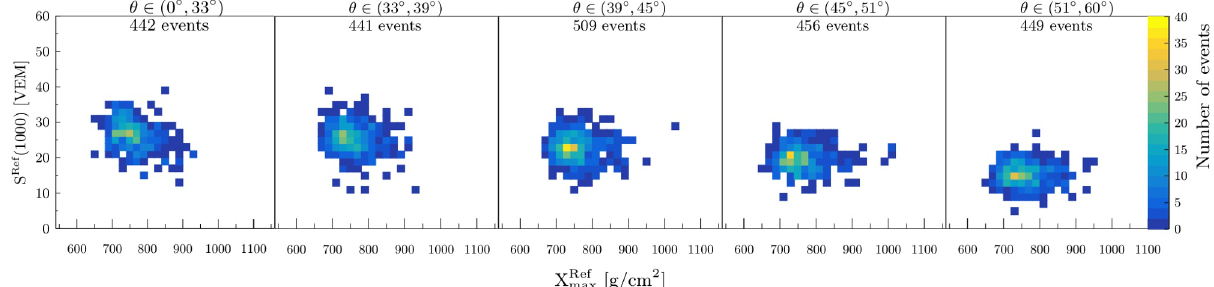
Figure 3: The two-dimensional distributions of S (1000) and X max for data measured by the Pierre Auger Observatory in the energy range 10 18 . 5 − 10 19 . 0 eV and divided into five zenith-angle ( θ ) bins.